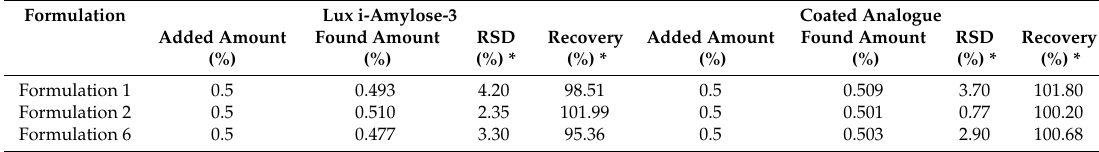
Table 4. Recovery results for selected